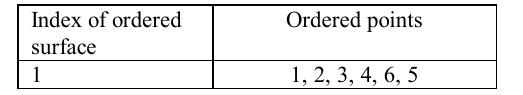
Table 4. Map structure with association of the index of the surface and the ordered indexes of the vertexes of this surface for Scenario 1 .